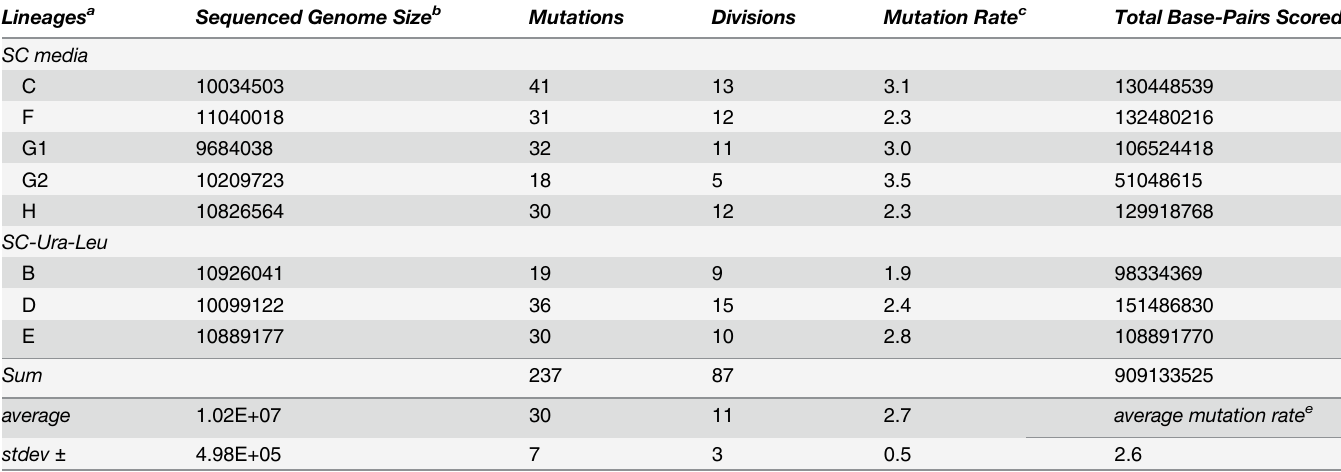
Table 1. Genome sizes and mutation rates of pol2-4 msh6 Δ sequenced lineages. Lineages a Sequenced Genome Size